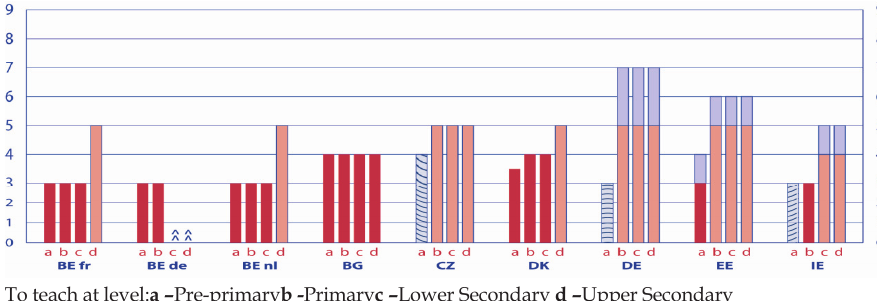
Figure 2. Required level and minimum length of initial teacher education for teachers from pre-primary to upper secondary education (ISCED 0, 1, 2 and 3), and the length of the induction period, 2010/11 (EACEA,